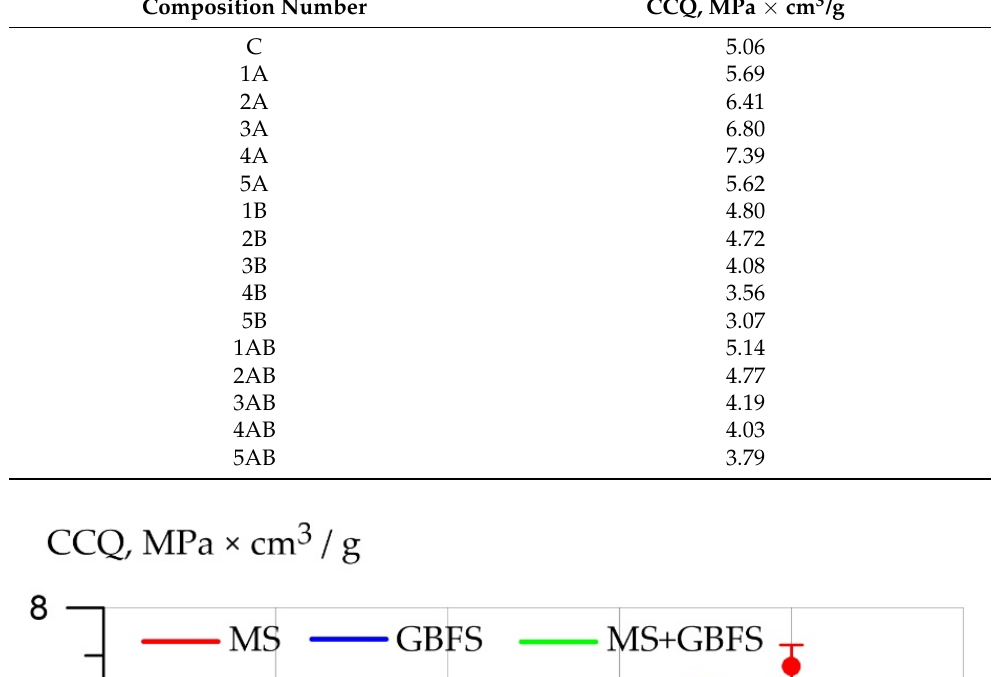
Table 10. Experimental values of the coefficients of structural quality of non-autoclaved aerated concrete.